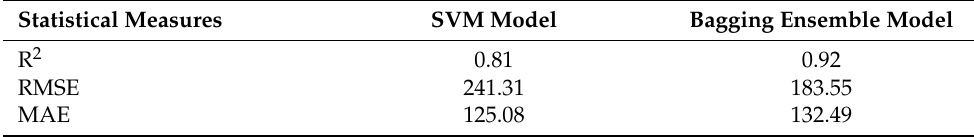
Figure 7. Random forest model; ( a ) regression analysis of experimental and predicted models; ( b ) distribution error of RF model. 5. Cross Validation In order to properly evaluate a model ’ s effectiveness, one must first determine the level of accuracy they require. Thus, validation is necessary for this purpose in order to guarantee the correctness of the prediction models. The K-fold validation test is used to verify the correctness of data via shuffled data [59]. This method is utilized to reduce the